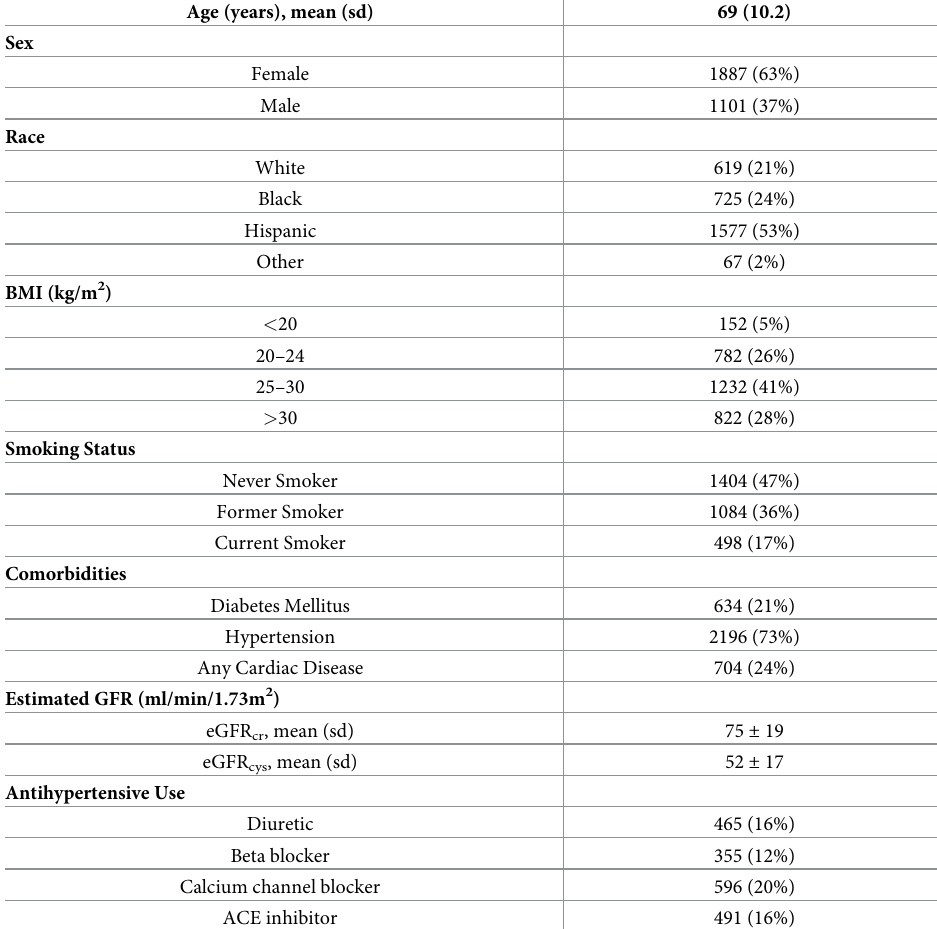
Table 1. Baseline characteristics of cohort.